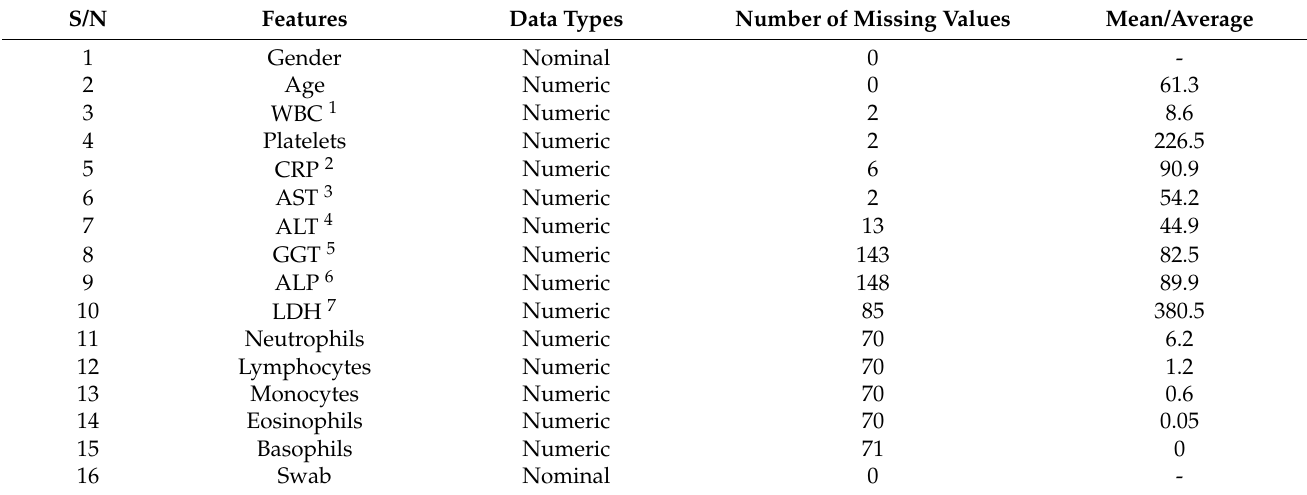
Table 2. Summary and description of the dataset.